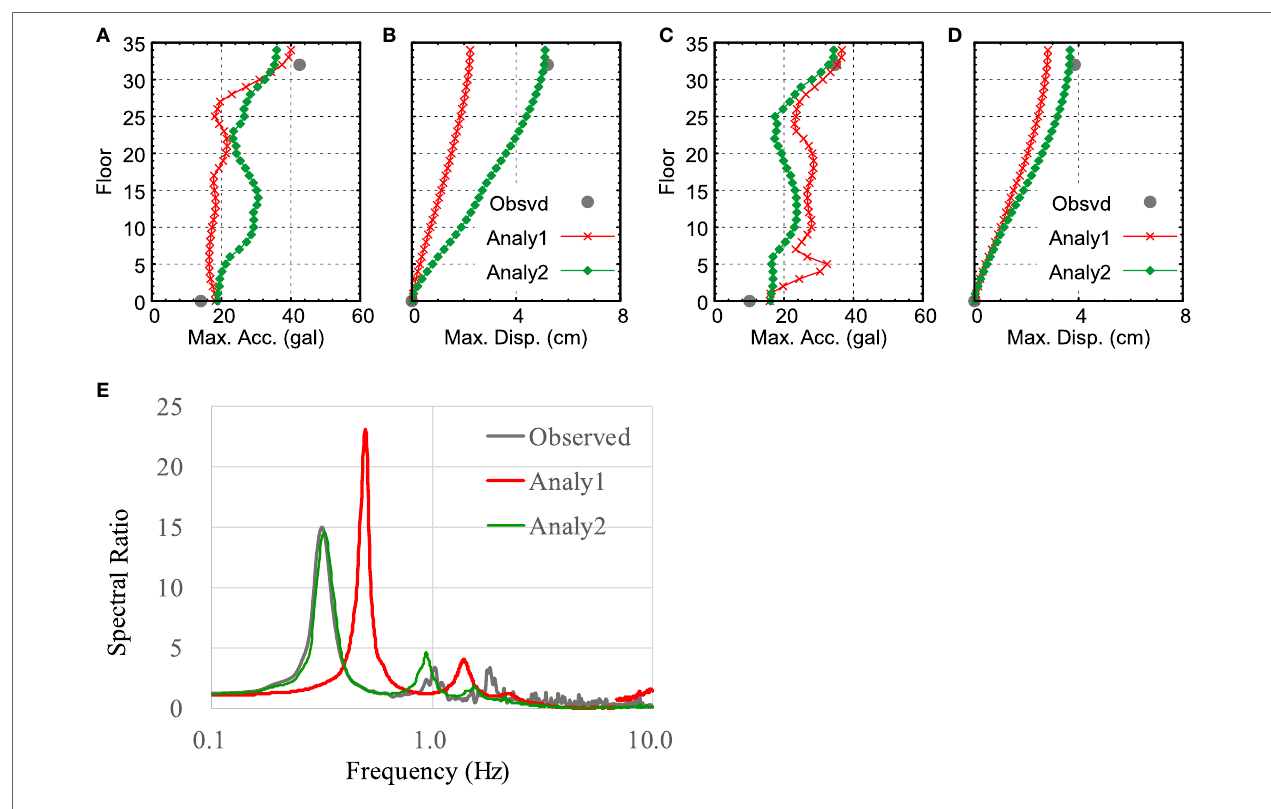
FigUre 11 | Comparison of maximum response for the 4/11 aftershock: (a) maximum acceleration (N–S direction), (B) maximum displacement (N–S direction), (c) maximum acceleration (E–W direction), (D) maximum displacement (E–W direction), and (e) transfer function between 32F and ground level for observed and analytical results (N–S direction).